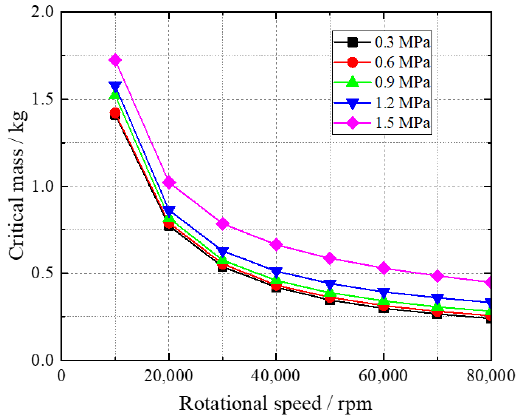
Figure 11. Critical mass of hydrogen gas bearings with ambient pressure.